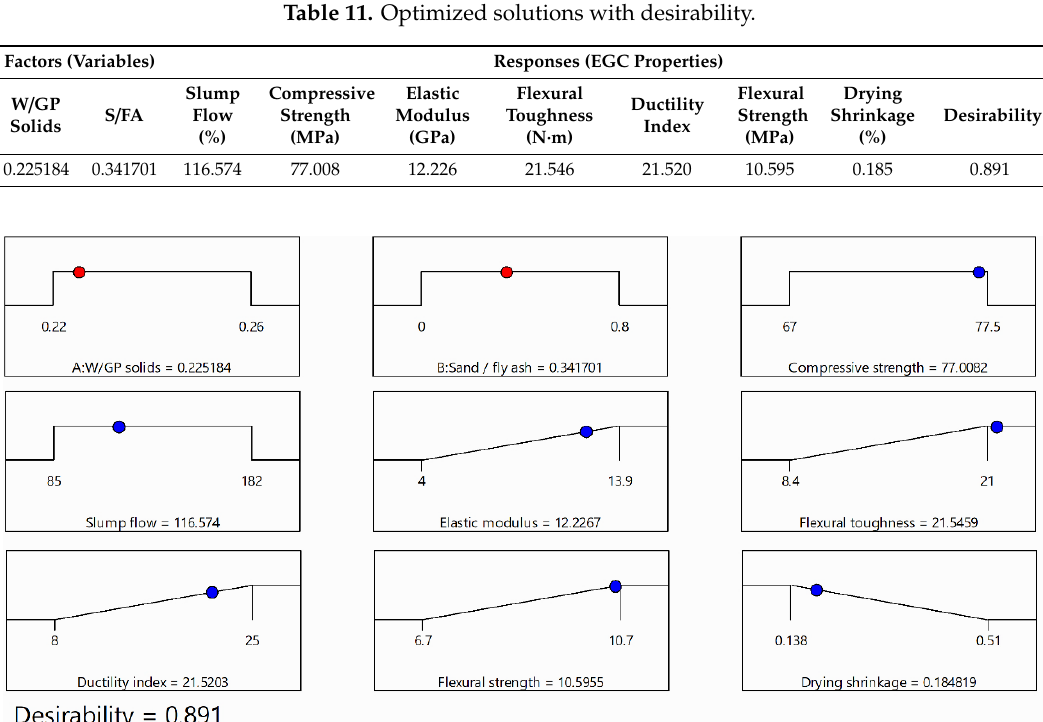
Figure 15. Ramps for multiobjective optimization of EGC . Table 10. Definitions of factors and responses in the multiobjective optimization problem.